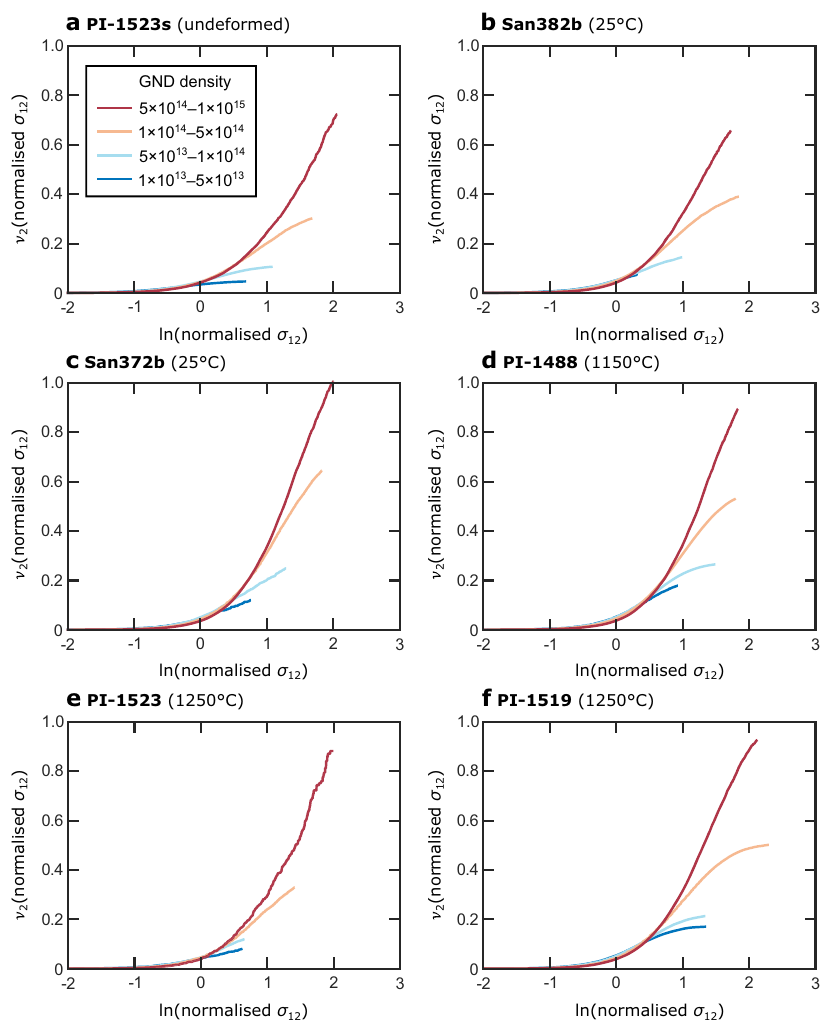
Fig. 5 Restricted second moments of subsets of the stress distributions based on GND density. Restricted second moments ( v 2 ) of the normalised σ 12 probability distributions in each aggregate ( a – f ). The σ 12 data from each sample are divided into subsets based on their corresponding GND densities, indicated in a , in the HR-EBSD